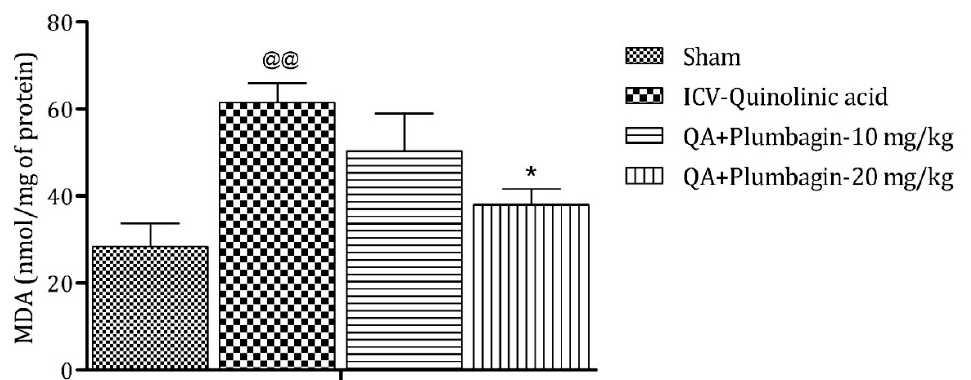
Figure 9. Effect of plumbagin on QA-induced variations in level of MDA in rats. Data represent mean ± SEM ( n = 6). @@ p < 0.01 as compared to sham group; * p < 0.05 as compared to QA-induced group.